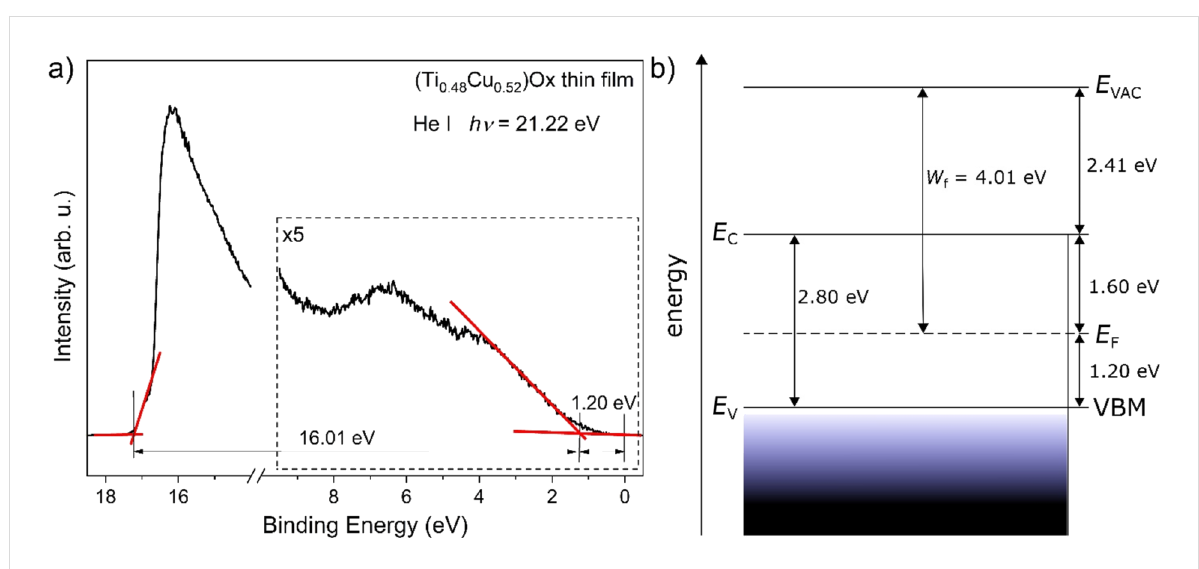
Figure 7: (a) Photoelectron spectrum of the valence band, (b) schematic energy diagram of the surface of the (Ti 0.48 Cu 0.52 )Ox thin film.